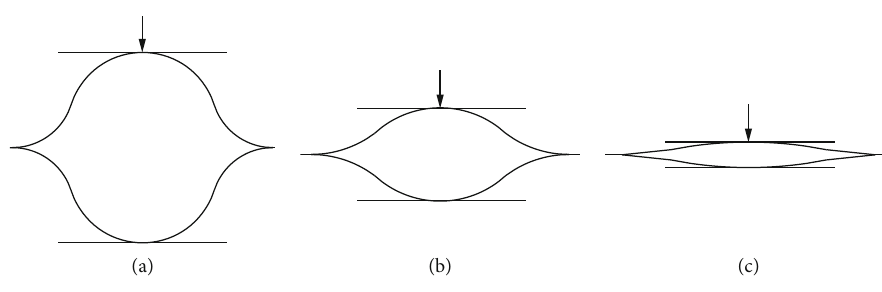
Figure 6: Pressure fl attening process of lenticular booms.